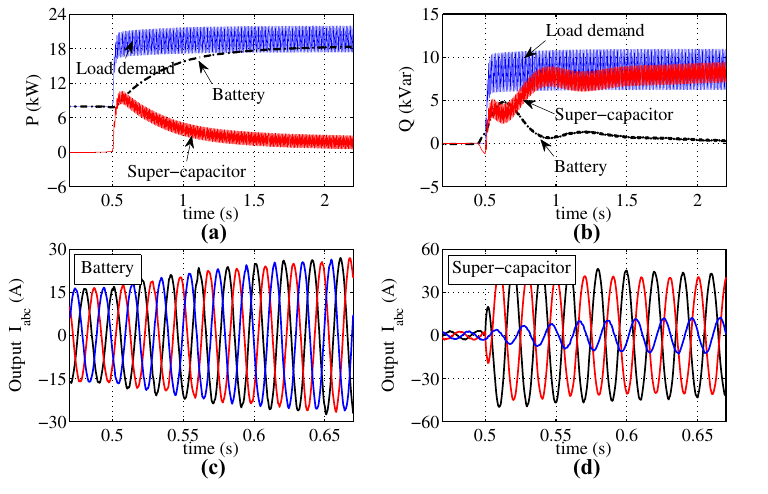
Figure 9. Comparison of battery and supercapacitor performance in hybrid